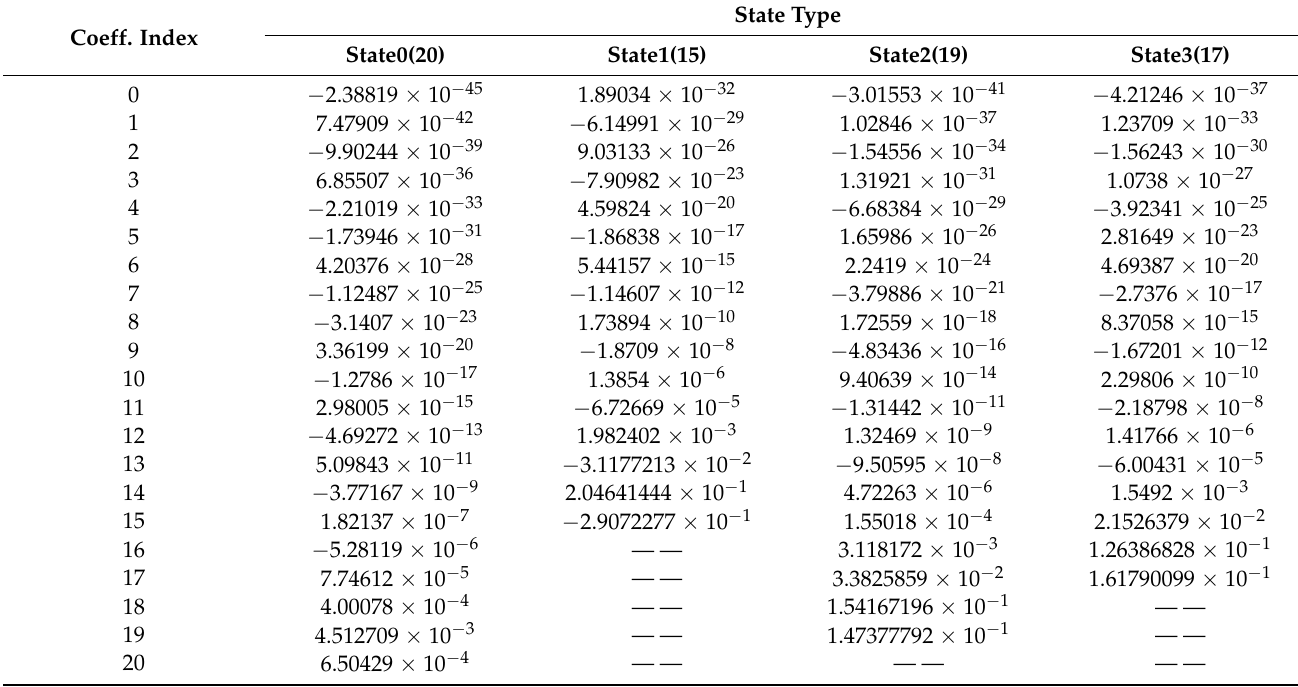
Table 7. The polynomial fitting coefficients of each state at the final time.